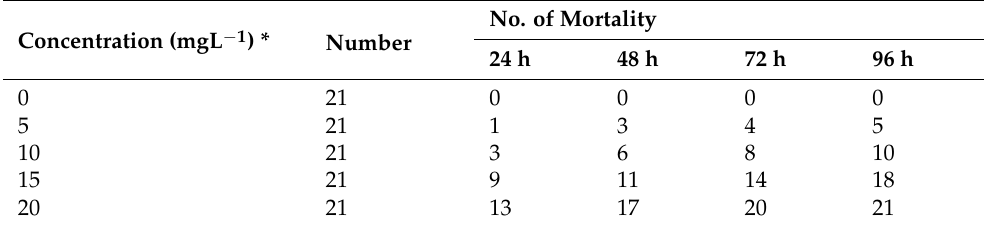
Table 1. Mortality of exposed C. capoeta to Ag-NPs.